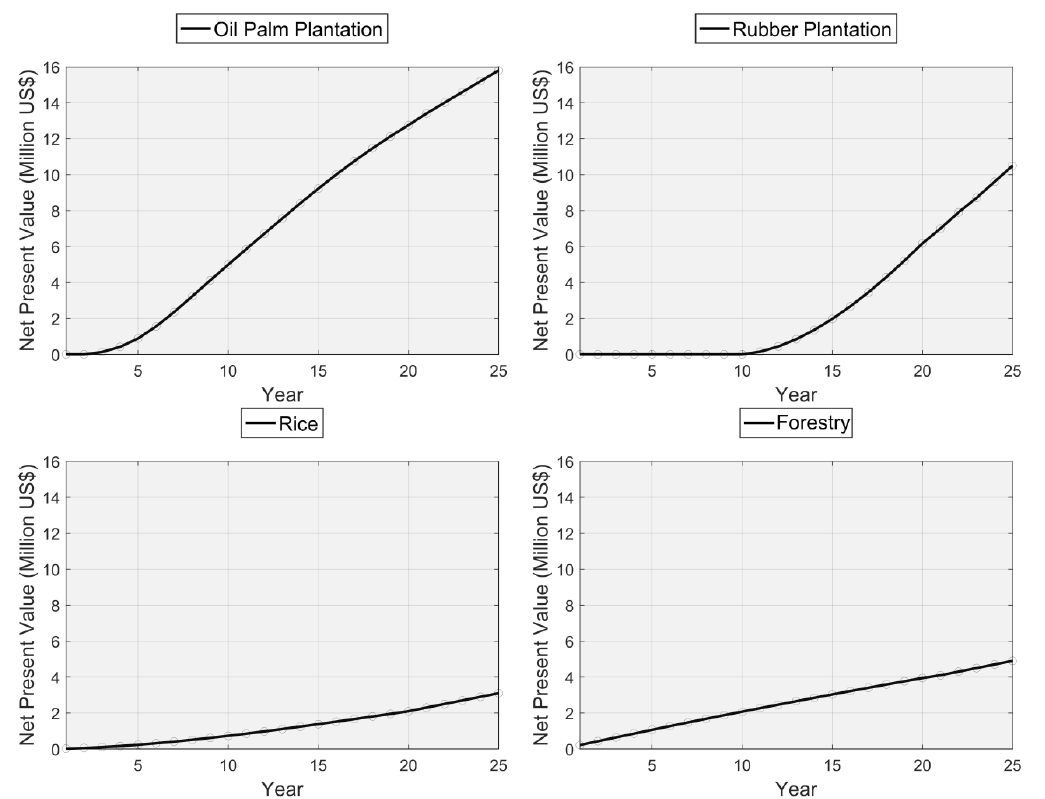
Figure 3. Net revenues for oil palm, rubber, rice, and forestry in the study area in twenty-five years under the business-as-usual (BAU) simulations.